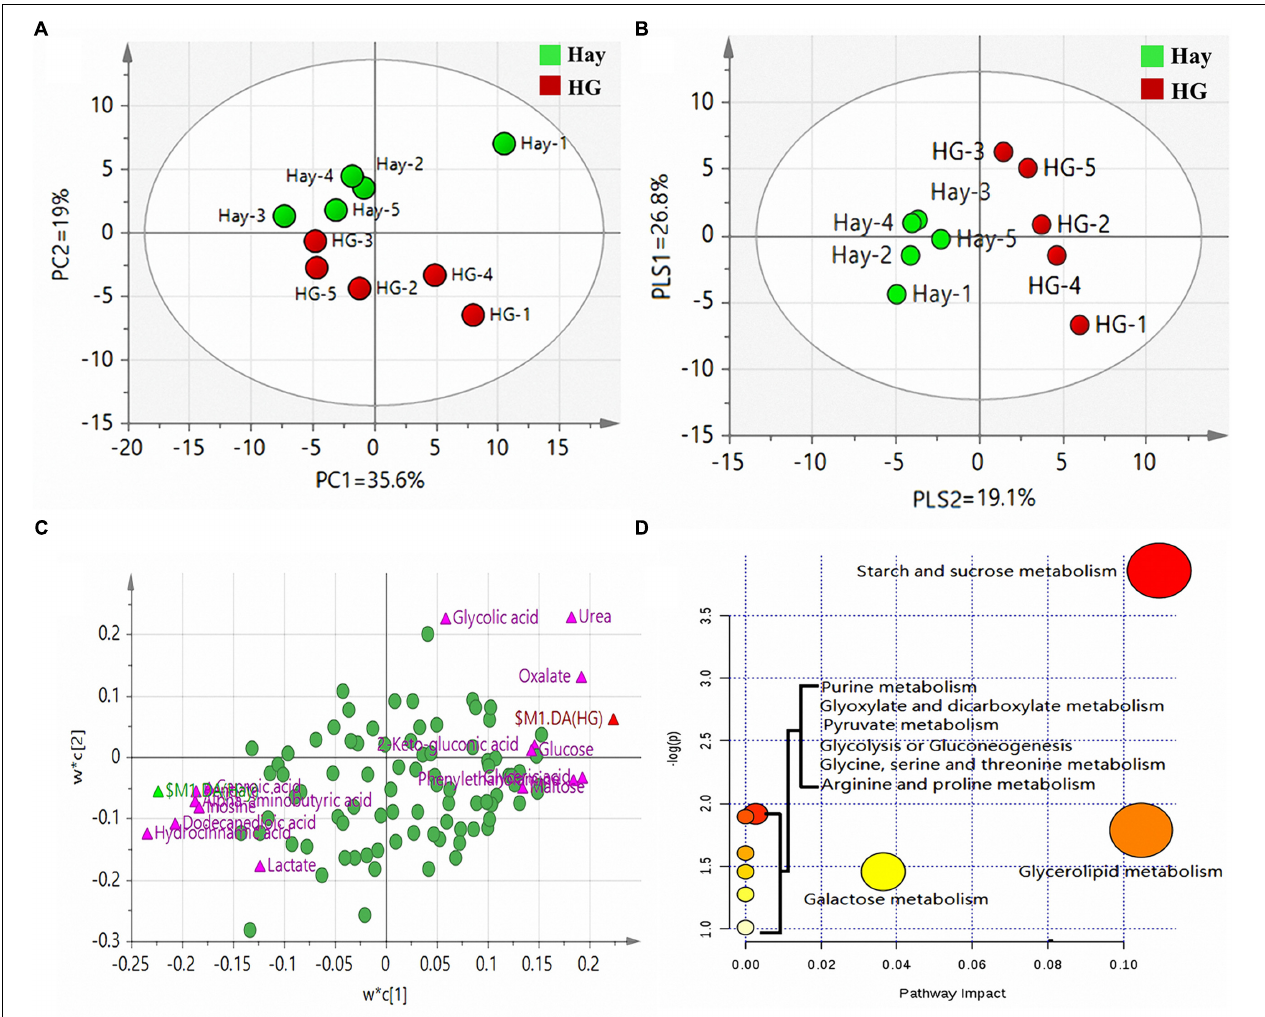
FIGURE 1 | (A) Principal component analysis (PCA) of metabolites in rumen epithelium in goats fed hay (Hay) and high grain (HG) diets. PC, the principal component that distinguish the Hay group and the HG group. PC1 is the first principal component; PC2 is the second principal component; PC1 could explained 35.6% of the variation; PC2 explained 19% of the variation. (B) Partial least squares discriminant analysis (PLS-DA) of metabolites in rumen epithelium in goats fed hay (Hay) and high grain (HG) diets. PLS, the principal component that distinguish the Hay group and the HG group. PLS1 is the first principal component; PLS2 is the second principal component. (C) Loading plot of the 91 commonly detected compounds projected into the PLS-DA model, the most important compounds (VIP > 1.2) responsible for the discrimination are labeled and colored in pink, and the other compounds were colored in green. Compounds are labeled by the names used in Table 1 . Variables with the same distance from 0 with similar positions are positively correlated. Those in the opposite direction are negatively correlated. (D) Pathway analysis. Plots depicting computed metabolic pathways as a function of –log ( p ) and pathway impact for the key differential metabolites. The impact is the pathway impact value calculated from pathway topology analysis. The larger size indicates higher pathway enrichment, and the darker color indicates higher pathway impact